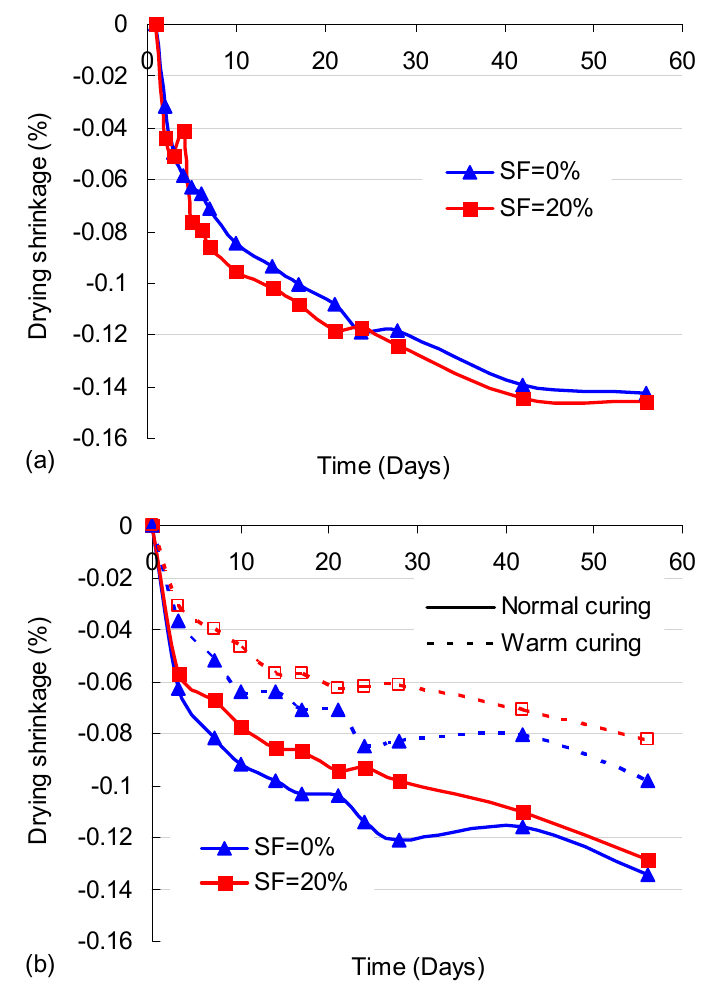
Figure 11. Drying shrinkage of plain concrete and RPC: ( a ) one-day air curing; ( b ) seven-day moist curing.